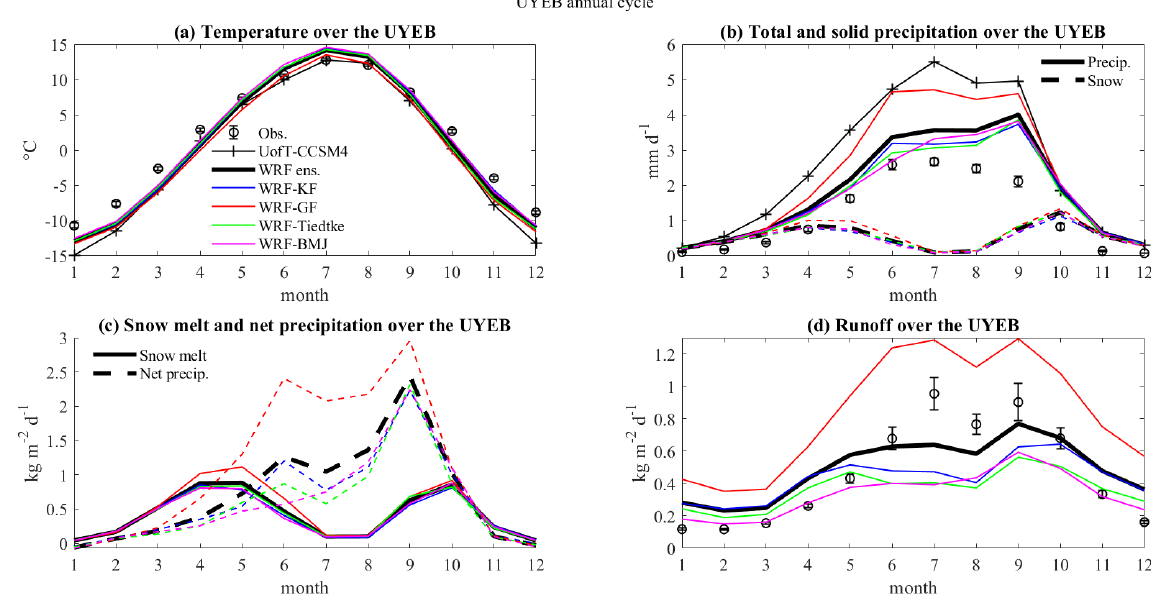
Figure 8. Average seasonal cycle over the UYEB: (a) temperature, (b) total and solid precipitation, (c) net precipitation and snowmelt, and (d) discharge at the hydrometric station and total runoff from WRF. The WRF ensemble average is shown in thick black lines, with the four individual ensemble members shown by blue, red, green, and magenta lines, respectively; observations are represented by open circles. Error bars in (a) , (b) , and (d) show the standard error of the mean.